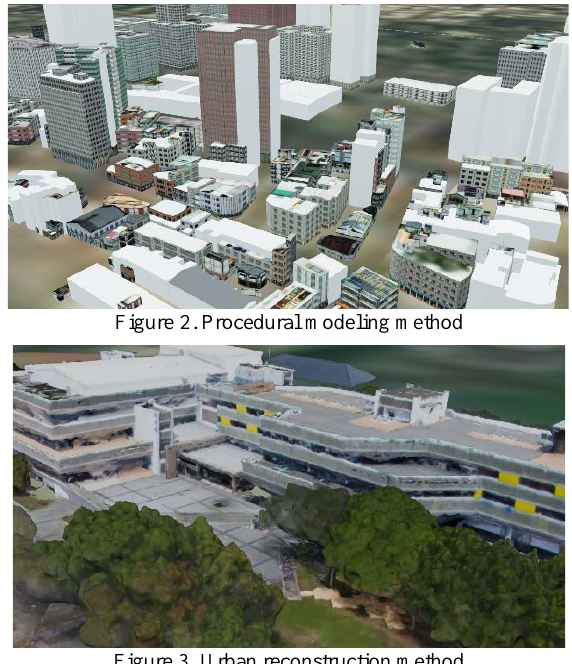
Figure 3. Urban reconstruction